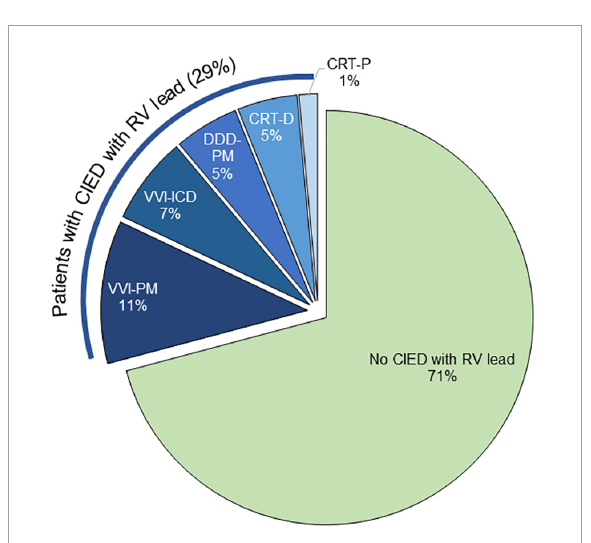
FIGURE2 Distribution of cardiac implantable electronic device (CIED) in the